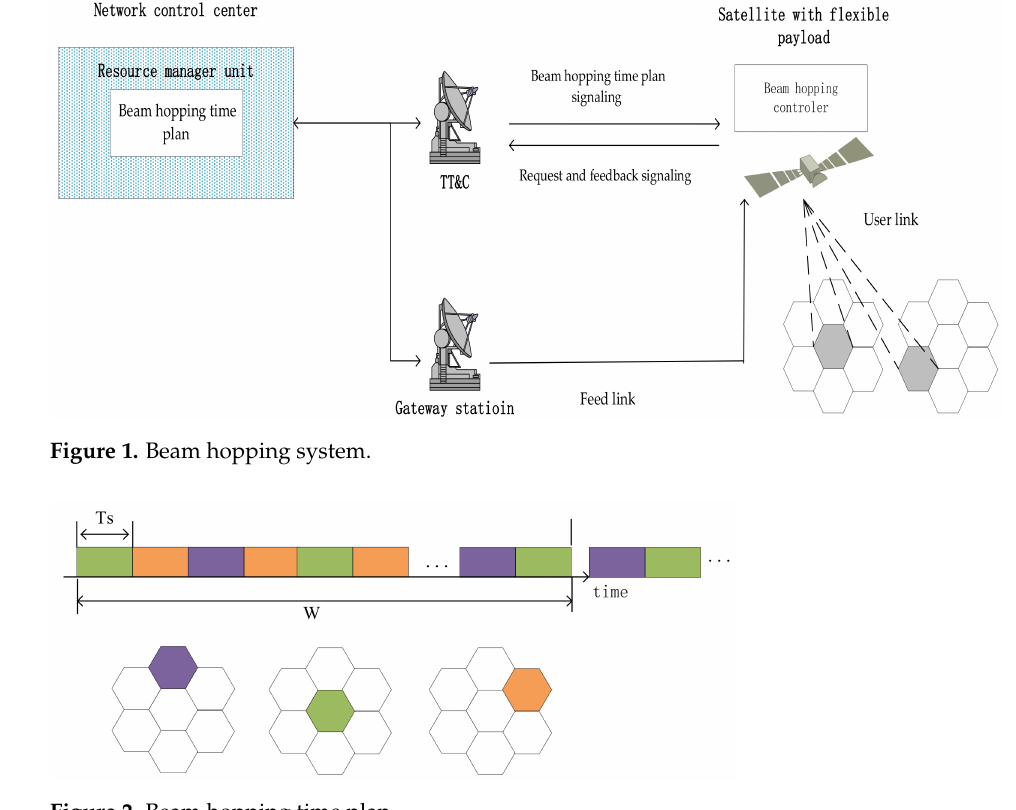
Figure 2. Beam hopping time